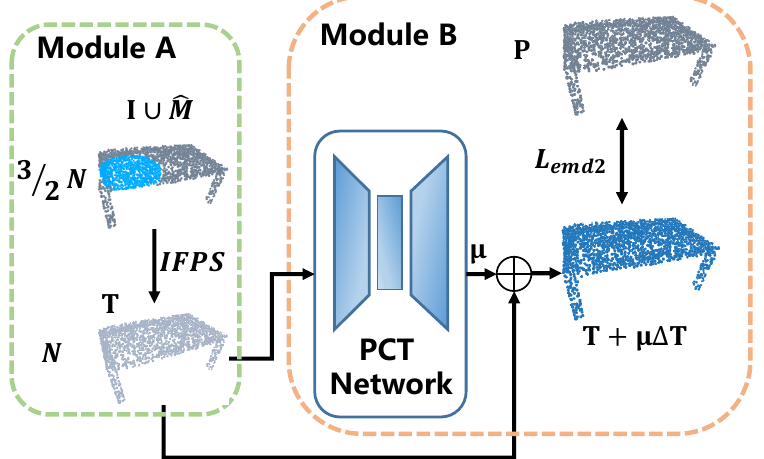
Figure 5. The architecture of our merging and sampling (Module A) and point-refiner network (Module